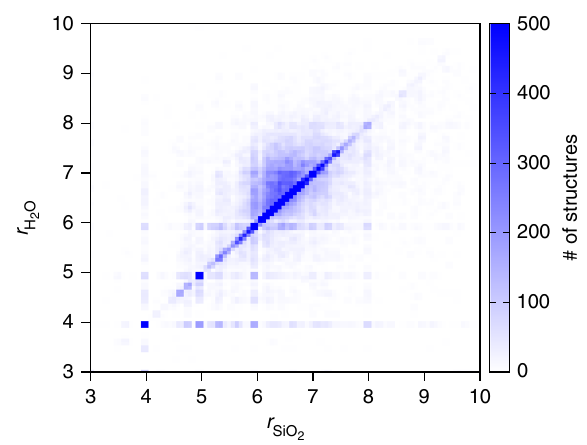
Fig. 1 Isomorphism between SiO 2 and H 2 O polymorphs. Correlation between the average ring sizes, r , of SiO 2 and H 2 O polymorphs. More than 1/3 of the ice polymorphs retain the ring statistics of their counterpart SiO 2